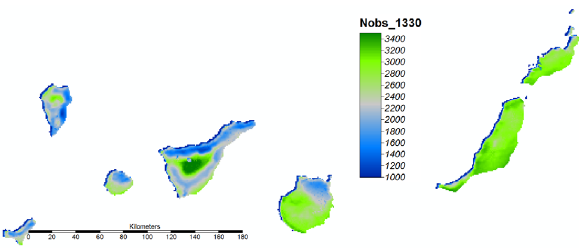
Figure 7. Number of cloud free observations at 13:30.